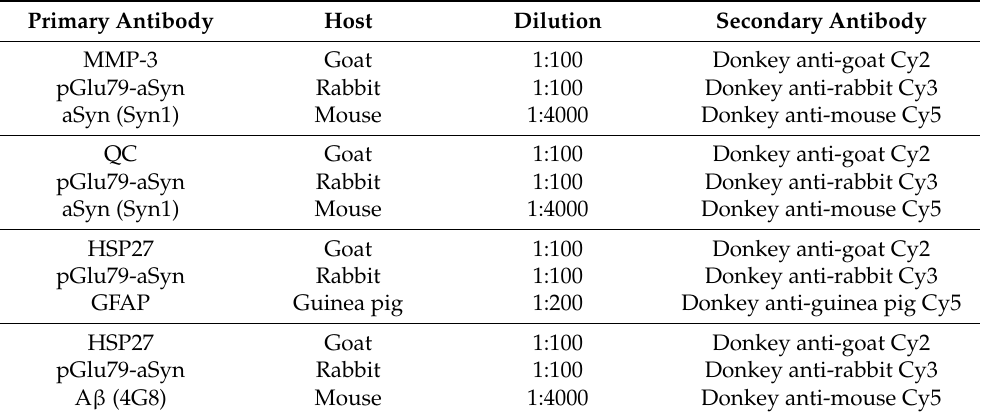
Table 2. Cocktails of primary and secondary antibodies used for triple immunofluorescent labeling in mouse brain